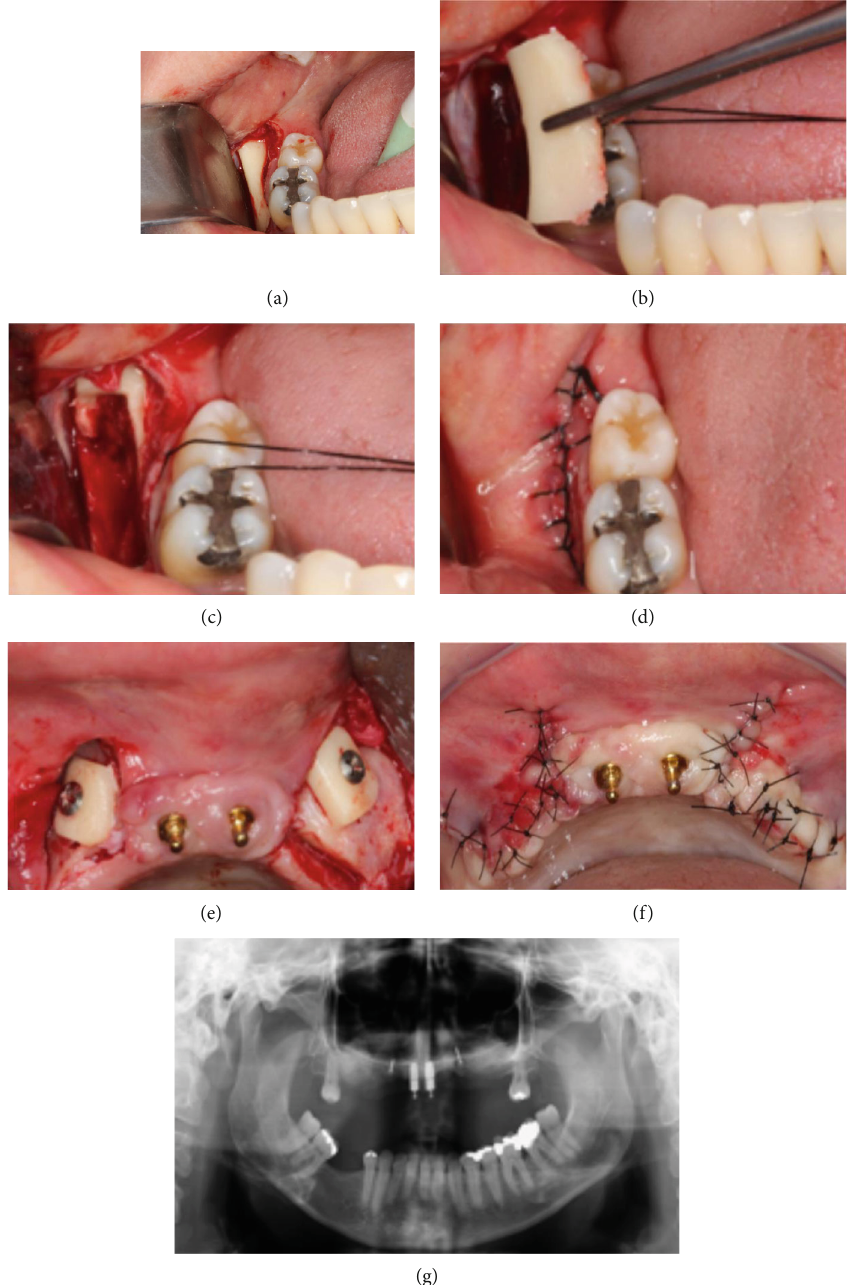
Figure 6: The third surgical approach was to install an onlay autogenous block bone graft harvested from the mandibular ramus. The graft was split and was installed in the receptor area in the posterior maxilla to augment the alveolar crest width and consequently to allow implant installation in an ideal tridimensional position (a – f). Panoramic radiography was taken immediately after graft placement